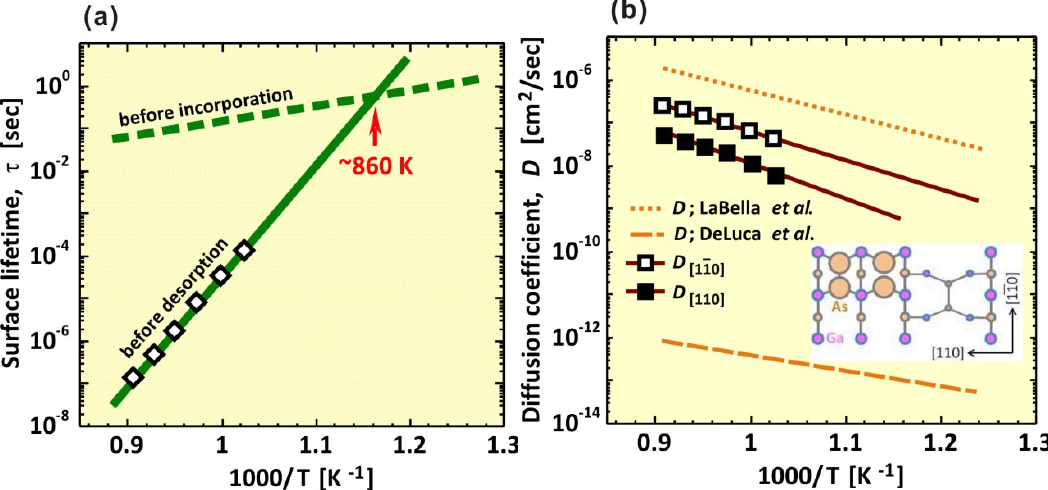
Figure 7. ( a ) Ga surface lifetime, τ ; and ( b ) diffusion coefficient, D , as a function of reciprocal temperature. Green solid and dashed lines are the calculated τ before desorption and τ before incorporation [66], respectively. Brown solid lines with open and filled squares are the (cid:1830) (cid:4670)(cid:2869)(cid:2869)(cid:3365)(cid:2868)(cid:4671) and D , respectively. The experimental results for the Ga diffusion [110] coefficient are also presented in the diagram by orange dotted ( - - - ) [69] and dashed lines ( – – – ) [65].